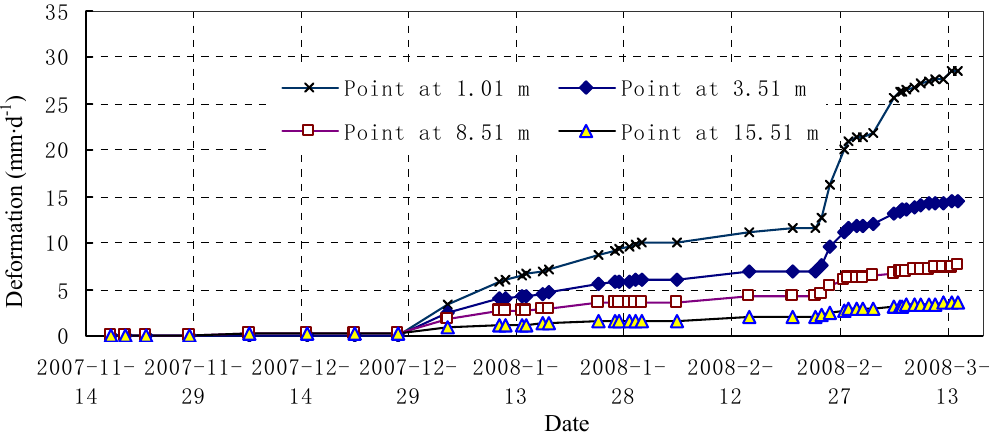
Figure 12. Deformation curve of the Mcf0+263 − 1 during excavation of the third